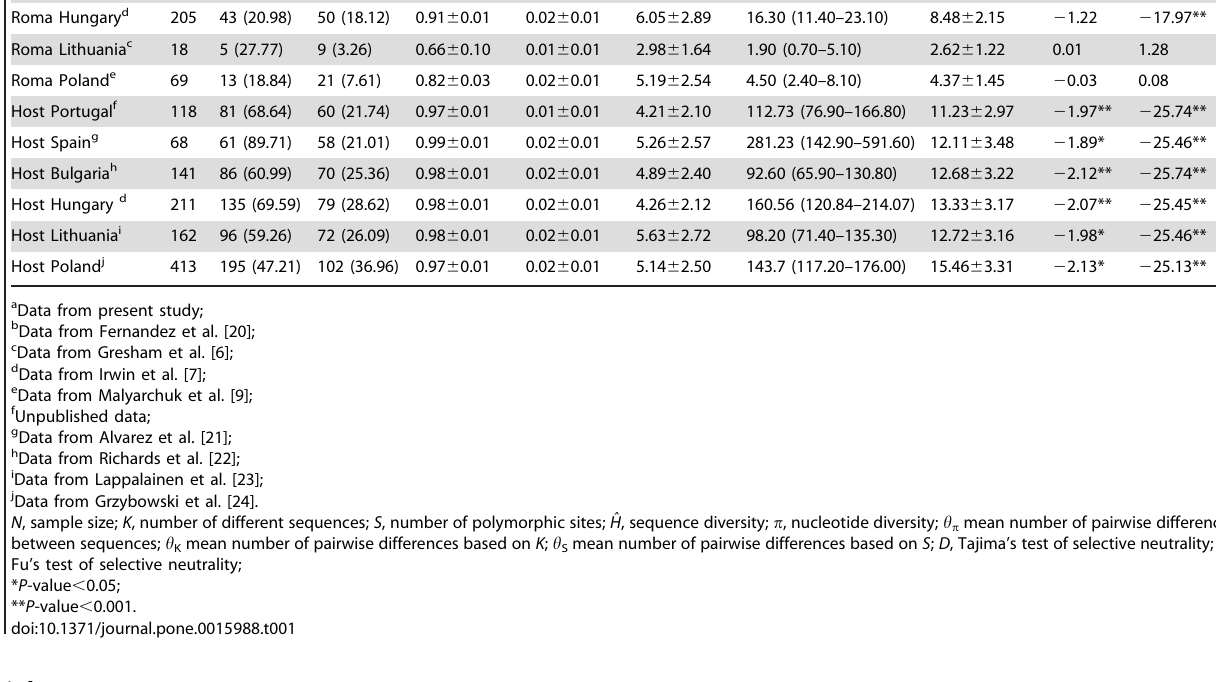
A median-joining network was generated to infer phylogenetic relationships between European Roma and Indian mtDNA